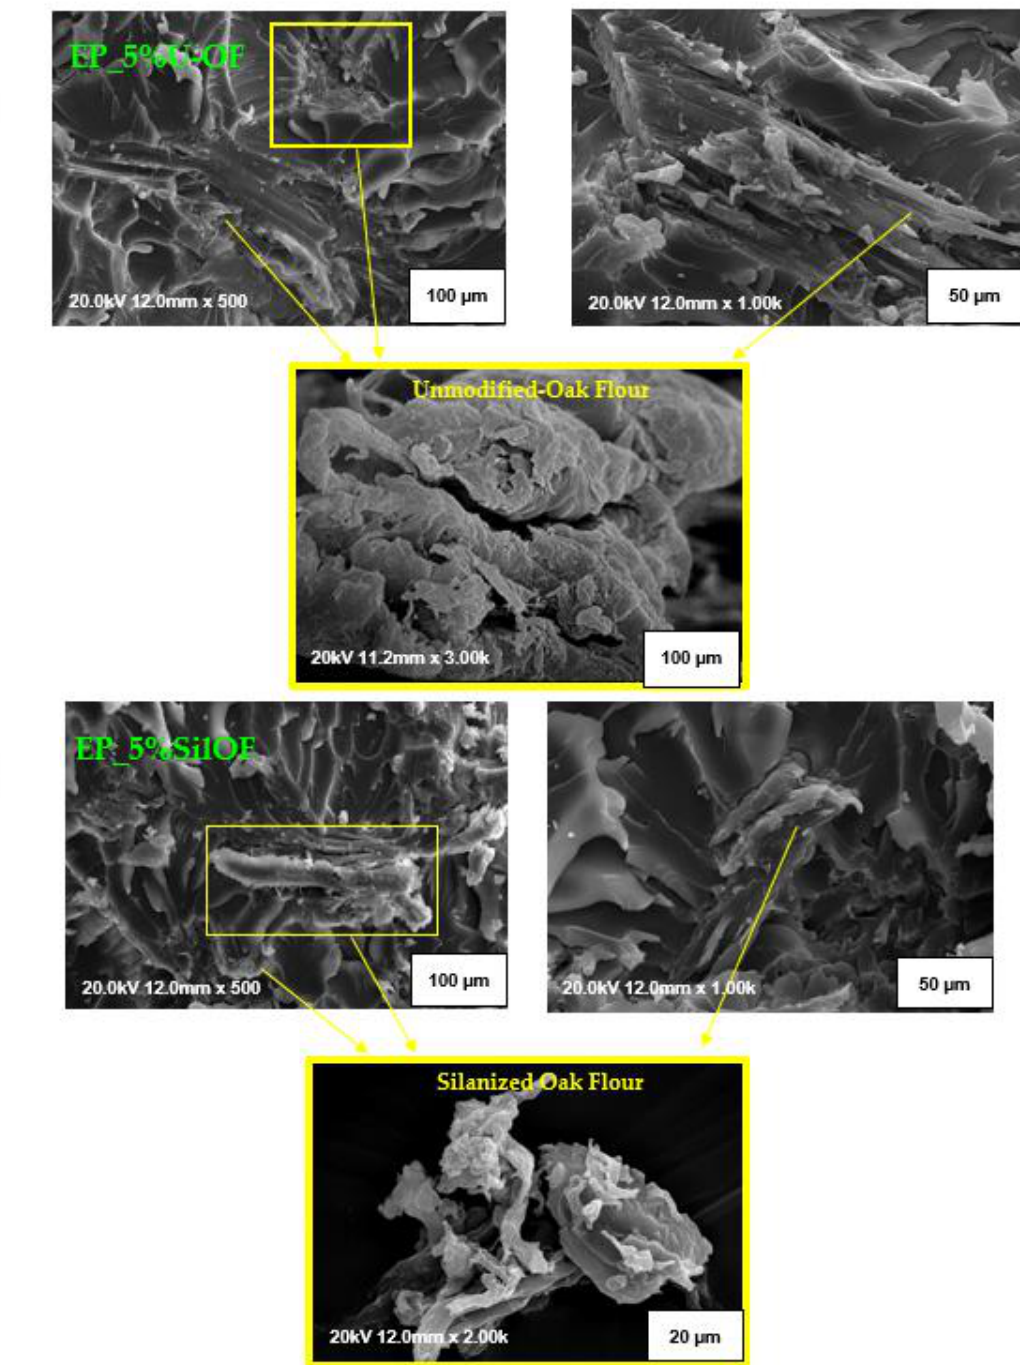
Figure 6. SEM micrographs of the impact fracture surface of the epoxy composites of EP_5%U-OF composition filled with 5 wt.% of unmodified wood flour ( A ), and EP_5%SilOF composition filled with 5 wt.% of silanized wood flour ( B ).